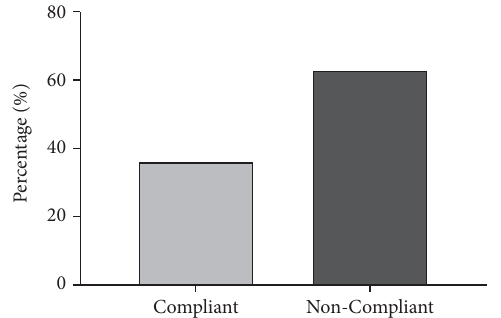
Figure 1: Prevalence of noncompliance with hypertension